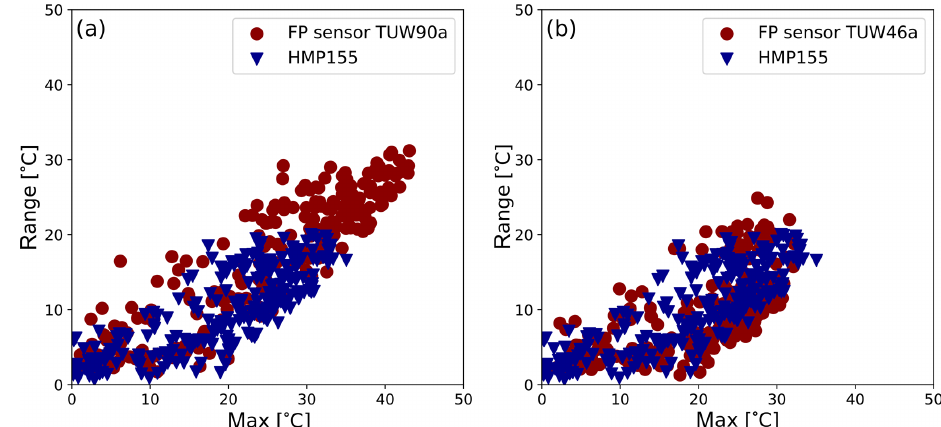
Figure 5. Scatter plots of the maximum temperature against the temperature range based on the conventional probe HMP155 and (a) the FP sensor TUW90a and (b) the FP sensor TUW46a.